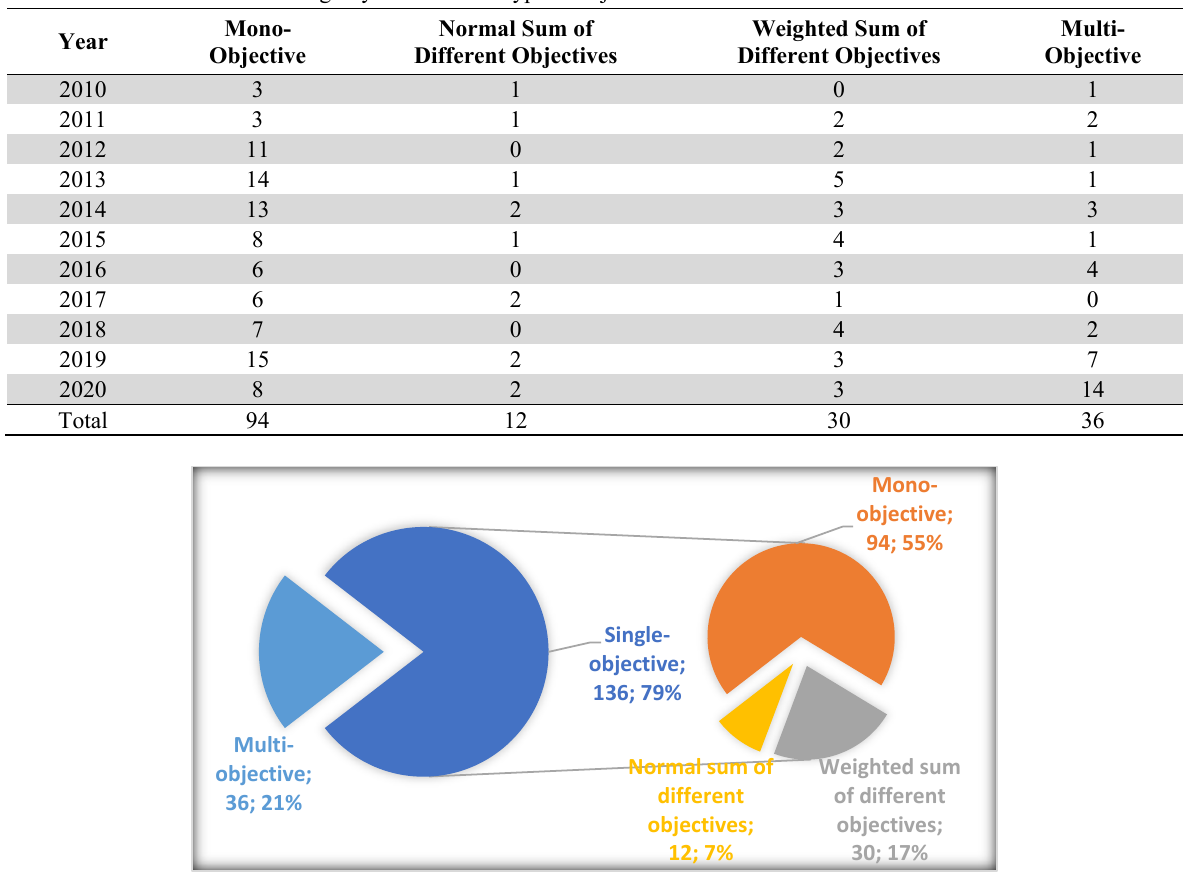
Fig. 11. Percentage distribution of HFS articles according to type of objectives